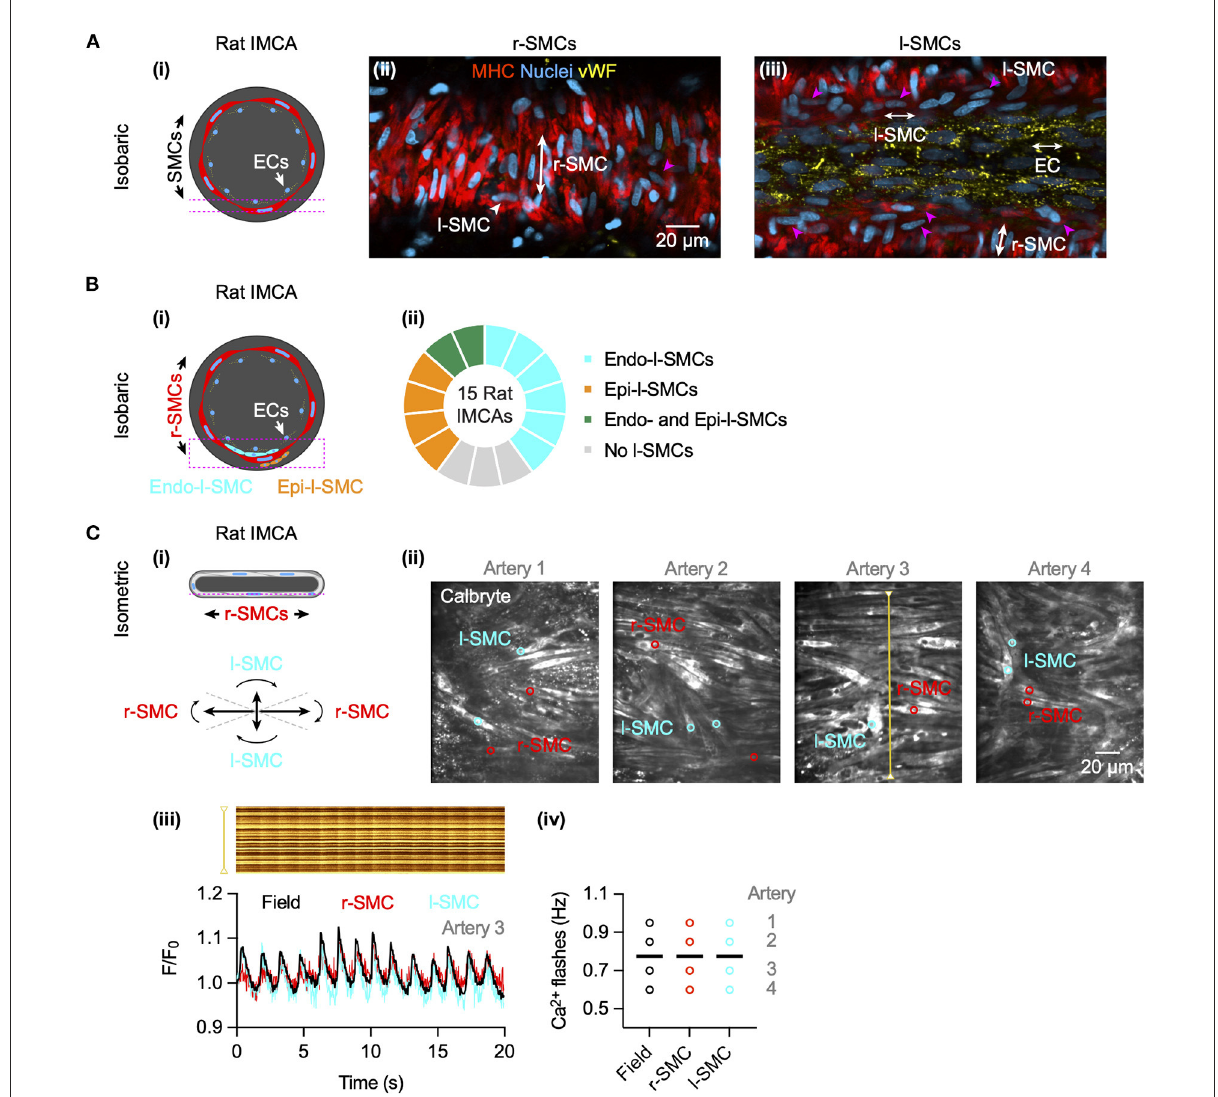
FIGURE9 Cell-cell contacts facilitate electrical communication in coronary arteries. (A) Rat septal IMCAs each developed myogenic tone when mounted for pressure myography (25.1 ± 2.8%, n = 15). Arteries were fixed and immunolabelled for SM-myosin heavy chain II to label SMCs and von Willebrand factor (vWF) for ECs. Both r-SMC and l-SMCs were visible, the latter clearly separate from ECs. The pink dashed lines in the schematic (i) show the focal planes for imaging the SMCs (ii) and ECs (iii) of the same artery. Pink arrowheads show examples of l-SMCs. Representative of 12 arteries (of 15 imaged) with l-SMCs. (B) In pressurized arteries (i) , l-SMCs were observed between the ECs and r-SMCs (endo-l-SMCs) and outside the r-SMCs (epi-l-SMCs). (ii) Most arteries had endo-l-SMCs (12 of 15), and some had both endo-l-SMCs and epi-l-SMCs (2 of 15). 3 arteries had < 5 l-SMCs in the z-stack (region indicated by dashed pink box in (i) , considered no l-SMCs. (C) In arteries set up in a confocal wire myography (i) SMCs were imaged at the bottom surface (focal plane indicated by dashed pink line). The r-SMCs were often in the same focal plane as the l-SMCs (angles for categorization shown). (ii) Confocal micrographs of 4 arteries are shown with regions used for average fluorescence (indicated by colored circles). (iii) The spatio-temporal characteristics of spontaneous SMC Ca 2 + flashes in Artery 3 are shown in line-scan analysis of the yellow line (upper), and corresponding average fluorescence intensity within a r-SMC (red) and l-SMC (cyan) and the whole field (black) as F/F 0 below. Summary data are shown in (iv) , each individual artery had simultaneous Ca 2 + flashes within all r-SMCs and l-SMCs, the frequency only varying between arteries (mean indicated by bars; 0.78 ± 0.08Hz, n =